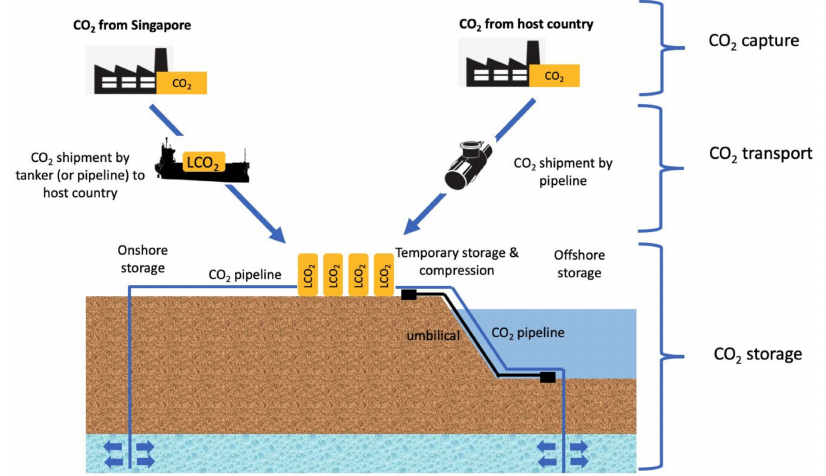
Figure 11. Southern Lights: a cross-border CCS project in the ASEAN